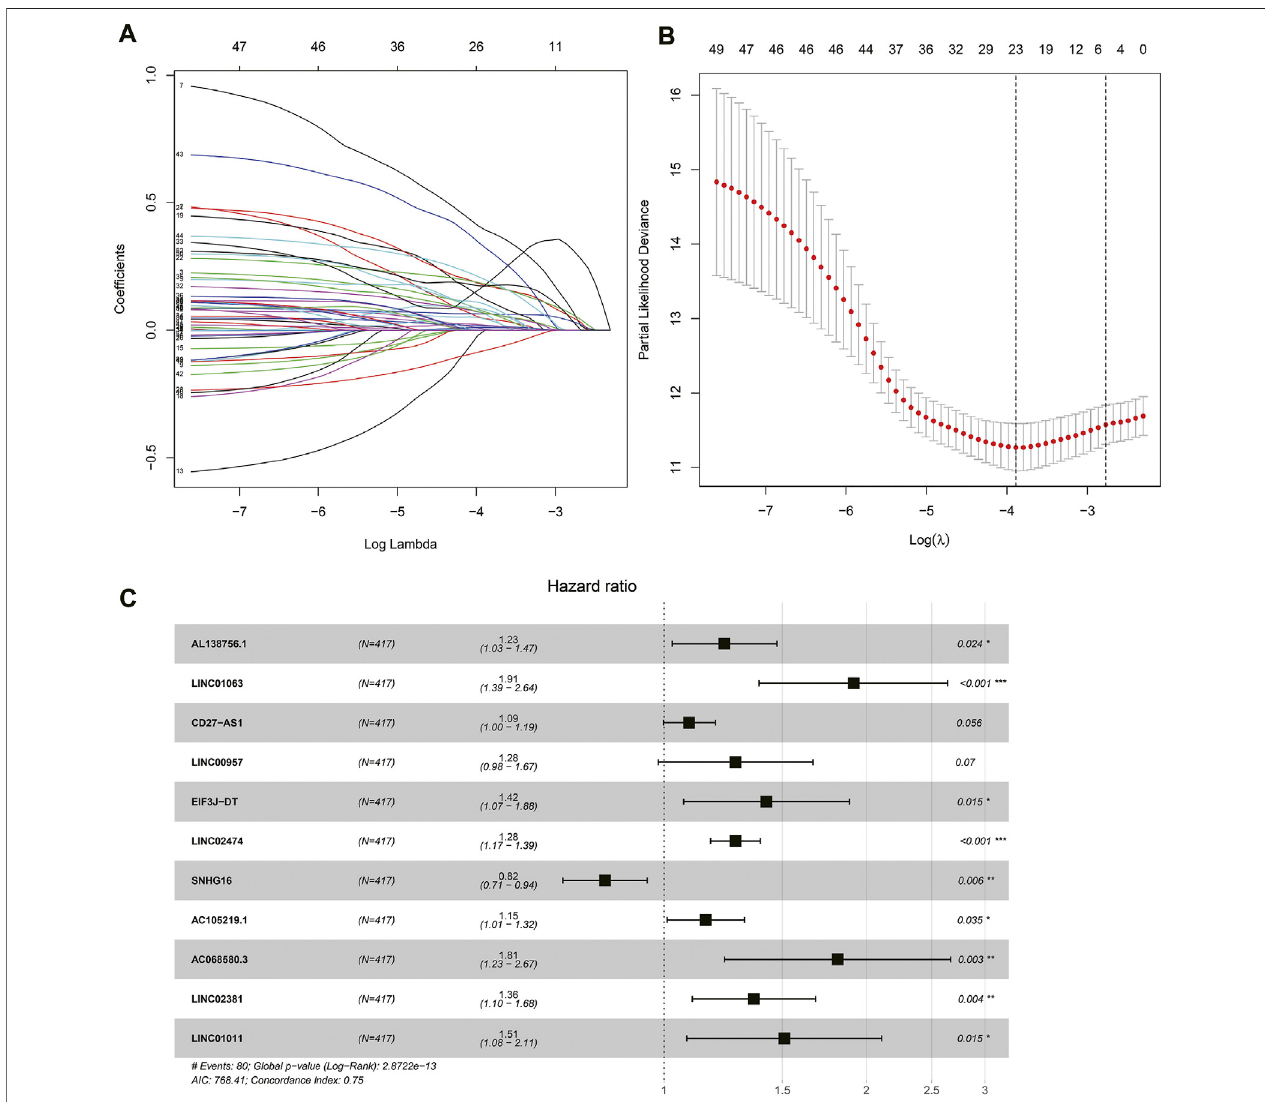
FIGURE2| AutophagyrelatedlncRNAsselectionbyCOXregressionandLASSOregressionanalysis. (A) Thelassoregressionmodelandcrossvalidationmethod were used to screen autophagy-related lncNRAs. (B) Cross validation results. The regression coef fi cient map of genes in the LASSO model. (C) Cox proportional hazards regression analysis of 11 prognostic